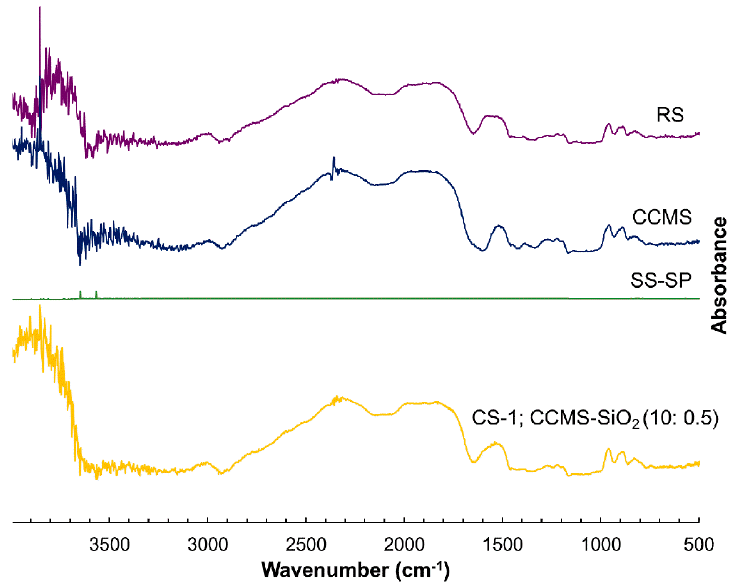
Figure 2. FT-IR spectra of native rice starch (RS), cross-linked carboxymethyl rice starch (CCMS), spray-dried silicon dioxide (SS-SP), and a co-processed rice starch-based excipient (CS-1; CCMS:SiO 2 , 10:0.5).